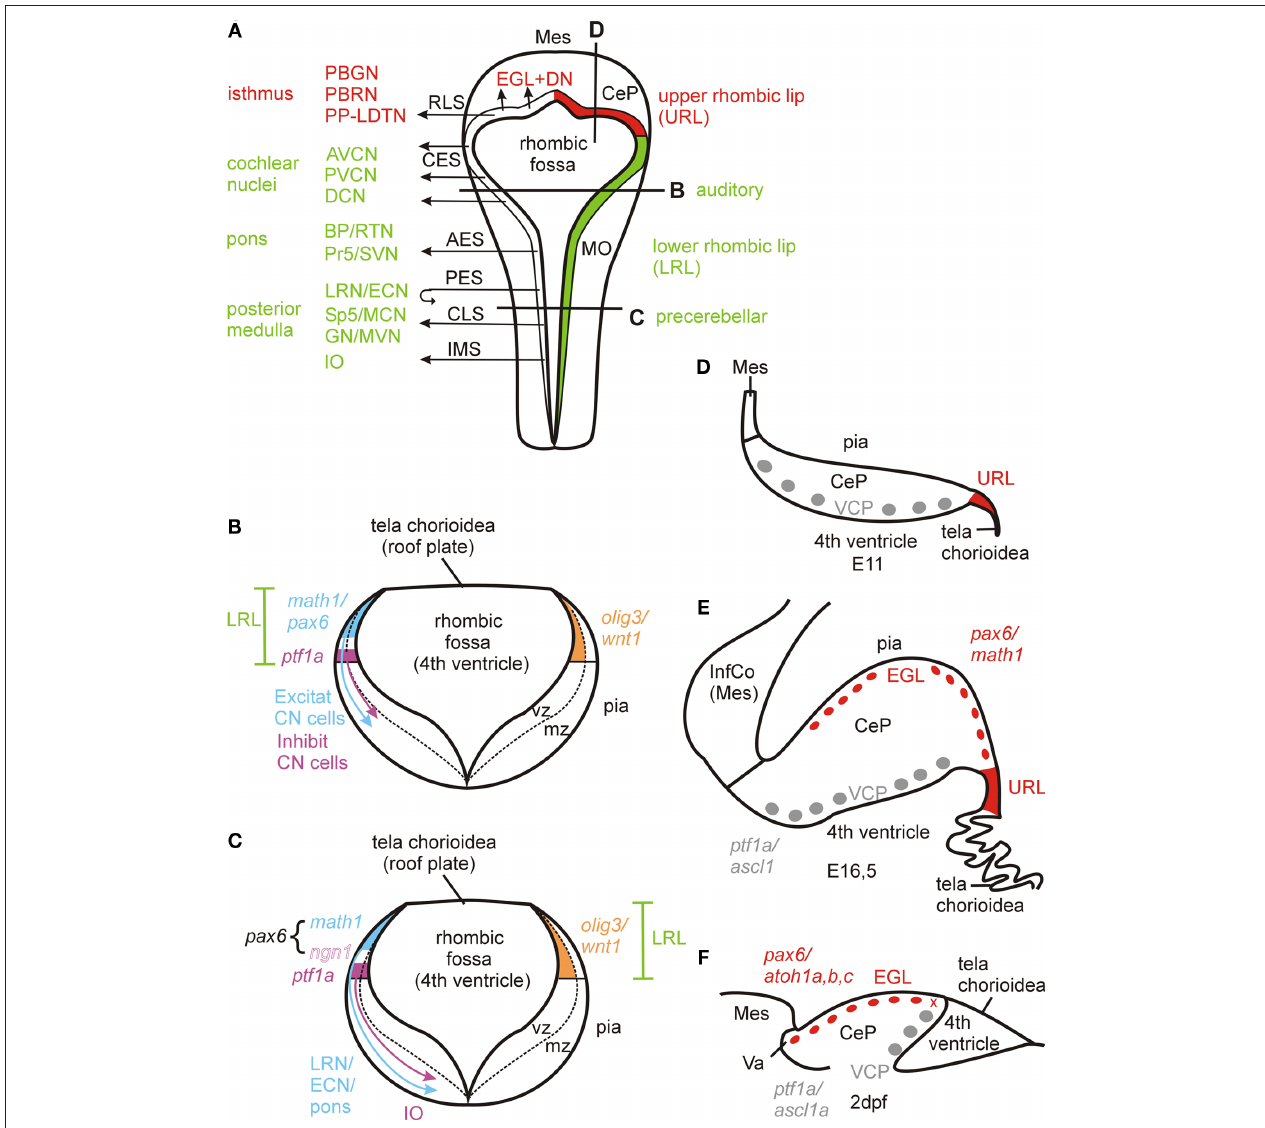
classical descriptions of the earlier upper rhombic lip include both (see text). (F) Sagittal section of zebrafish cerebellar plate at 2 dpf (redrawn after Kani et al., 2010). The x symbol indicates the hypothetical site of the ventricular origin of subpial atoh1 positive cells and, thus, the structure corresponding to